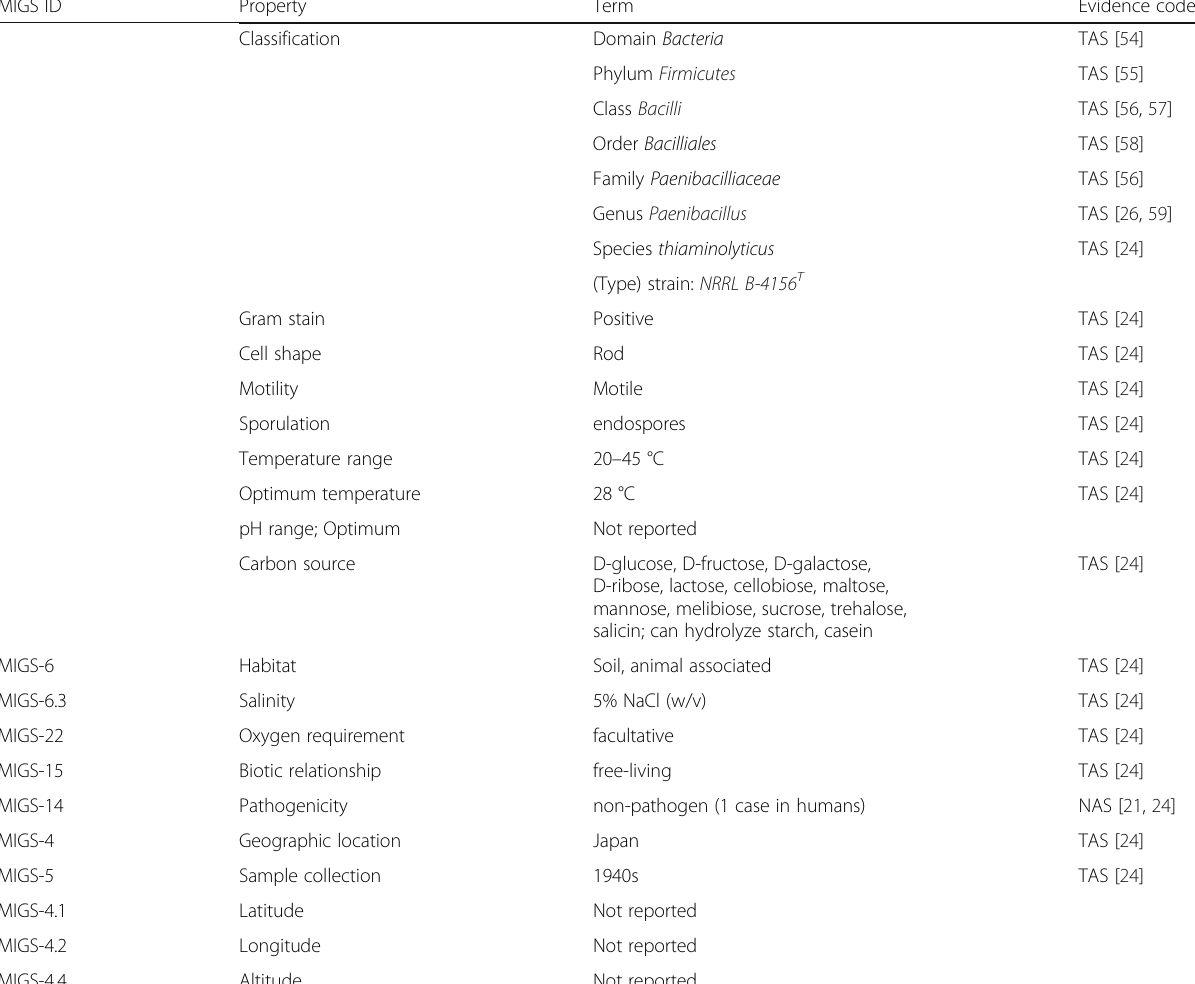
Table 2 Classification and general features of P. thiaminolyticus NRRL B-4156